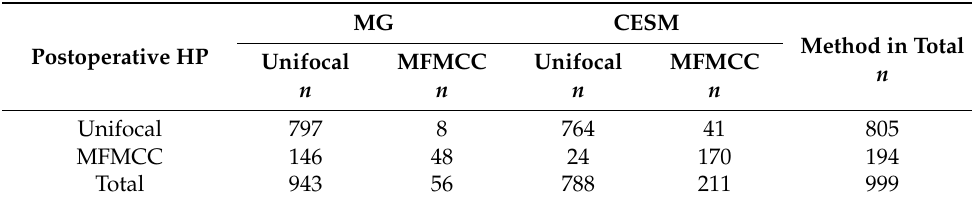
Table 2. Compliance in identification of multifocal-multicentric breast cancers (MFMCC) in digital MG and CESM confirmed in the histopathological examination (HP).